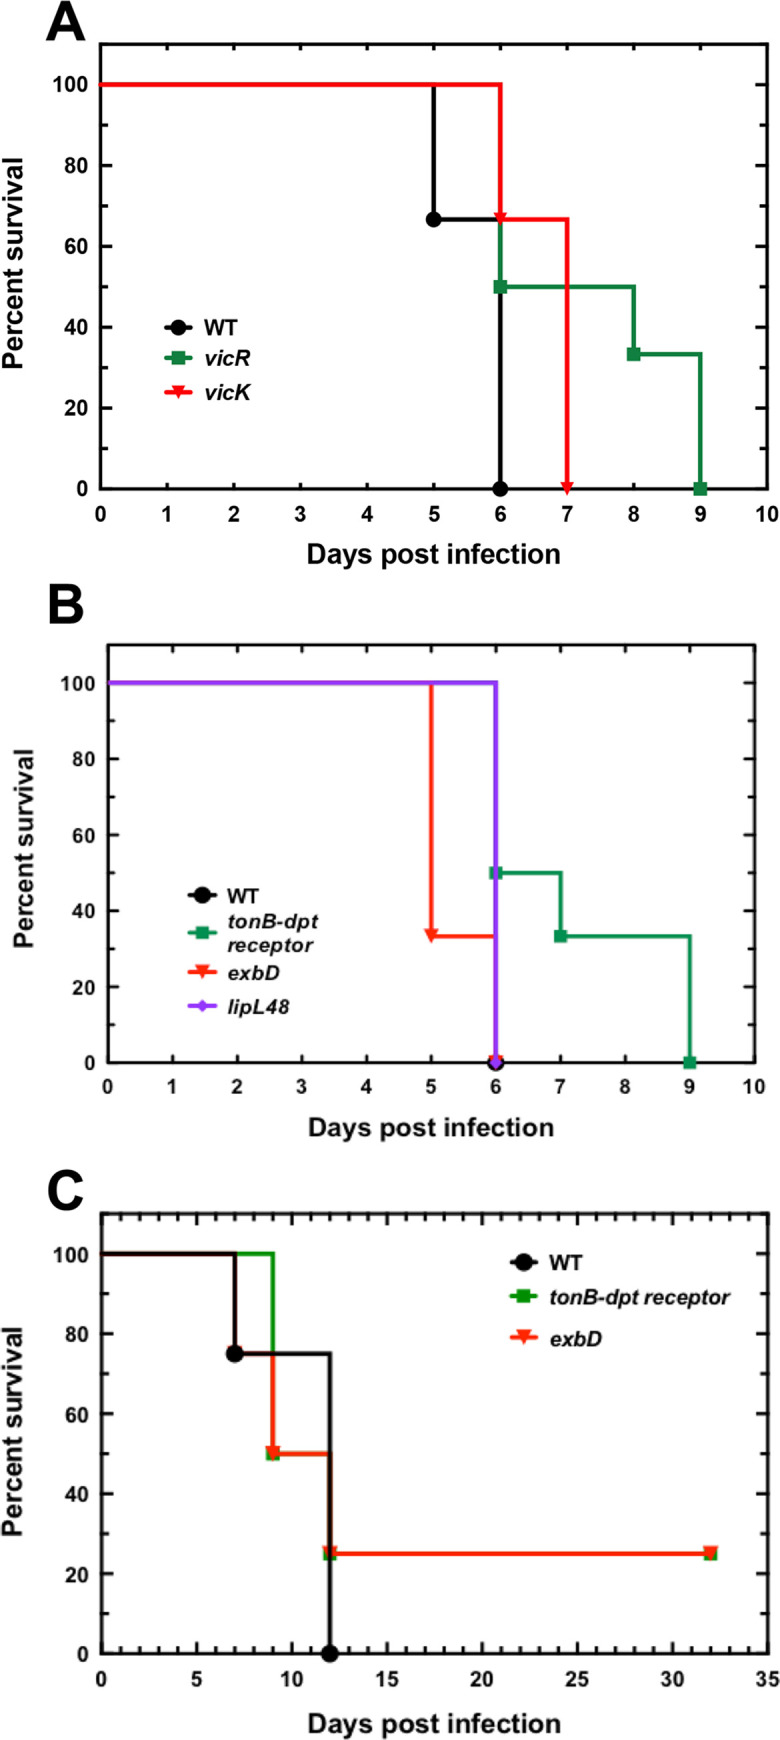
Role of PerR-controlled ORFs in Leptospira virulence.106 of WT, vicK (Man1448) and vicR (Man899) mutant strains (A), or the tonB-dpt receptor (Man1022), exbD (Man782), lipl48 (Man1089) mutant strains (B) or 104 of WT, exbD (Man782), or the tonB-dpt receptor (Man1022) mutant strains (C) were injected intraperitoneally in hamsters (n = 4–8) as described in Material and Methods section.